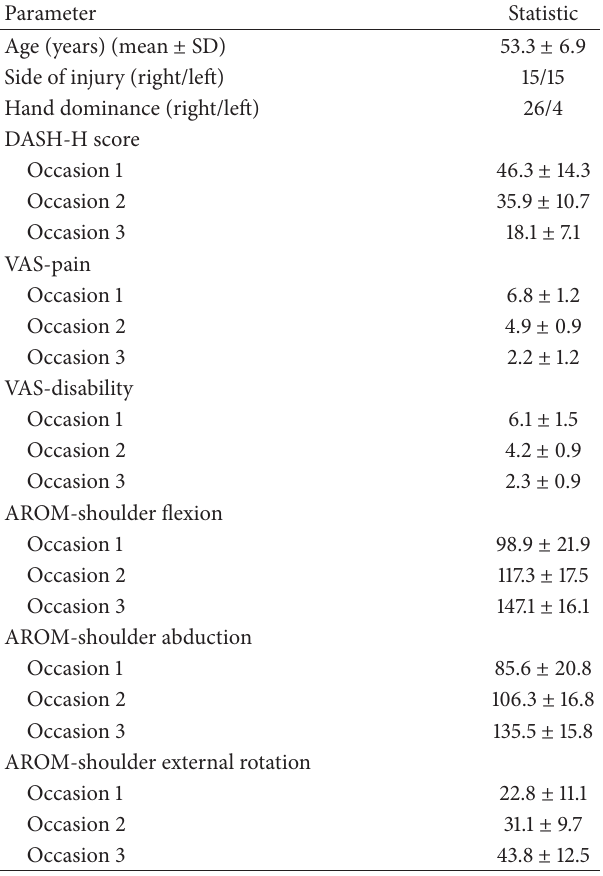
Table 1: Characteristics of the participants ( 𝑁 = 30).